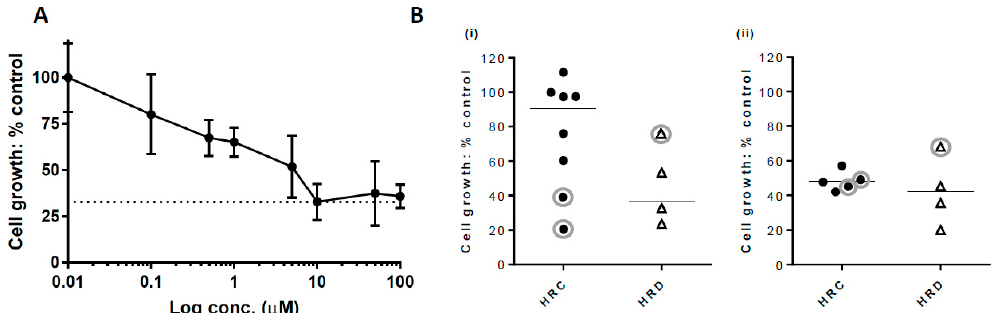
Figure 3. Growth inhibition by rucaparib treatment ( A ) Growth inhibition curve of PA008 culture (HRD) with rucaparib. Cell proliferation was assessed by sulforhodamine B assay. Data are the mean values of six repeats for each concentration, with error bars demonstrating SD. Cell growth, relative to control following exposure to 10 µM of rucaparib, was 32.8% (dotted line). ( B ) Cell growth distribution by HRR status after treatment with 10 µM of rucaparib. Values were calculated as growth following rucaparib treatment as a percentage of DMSO only control by sulforhodamine B (SRB). Data are the mean values of six repeats. ( i ) % cell growth: control of all cultures treated continuously for 10 days. Non-circled data points are fresh cultures, circled data points are cultures that were re-established from thawed cryopreserved cells. Mean values, represented by horizontal bars are for fresh cultures only (excluding three circled data points) ( ii ); % cell growth: control of thawed cultures treated for 48 h, circled data points represent the samples that were also treated continuously in (i).